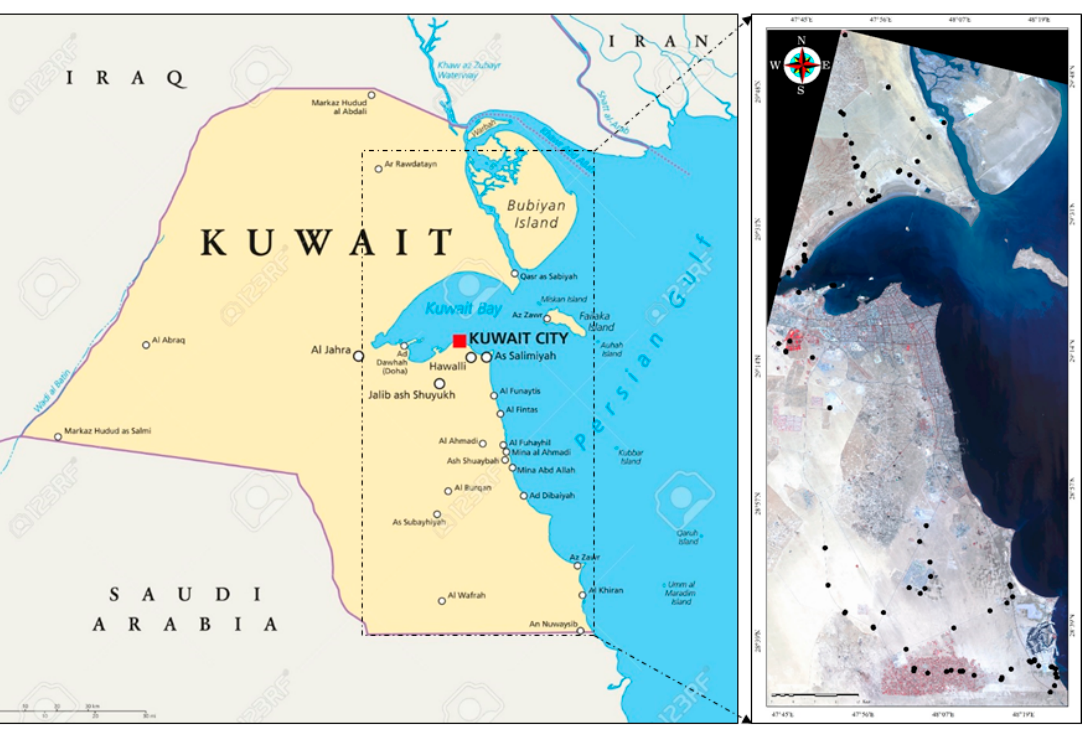
Figure 2. Map showing the study area and sampling locations.